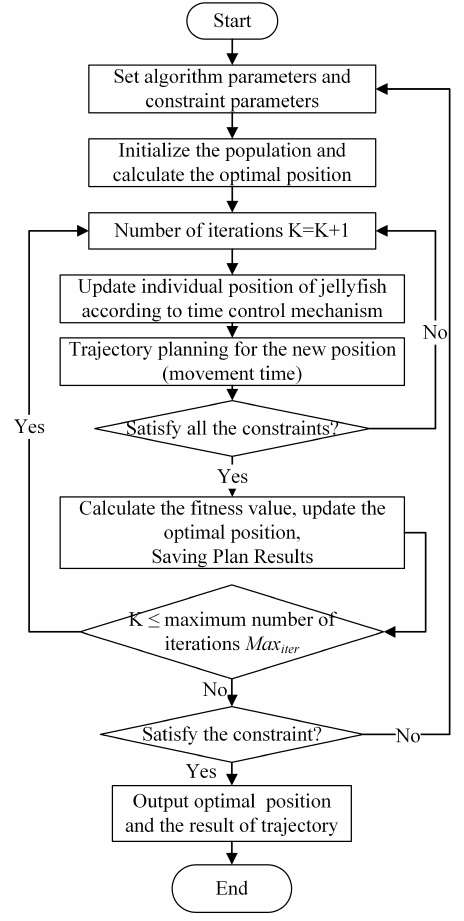
Figure 6. The flow chart of the solution